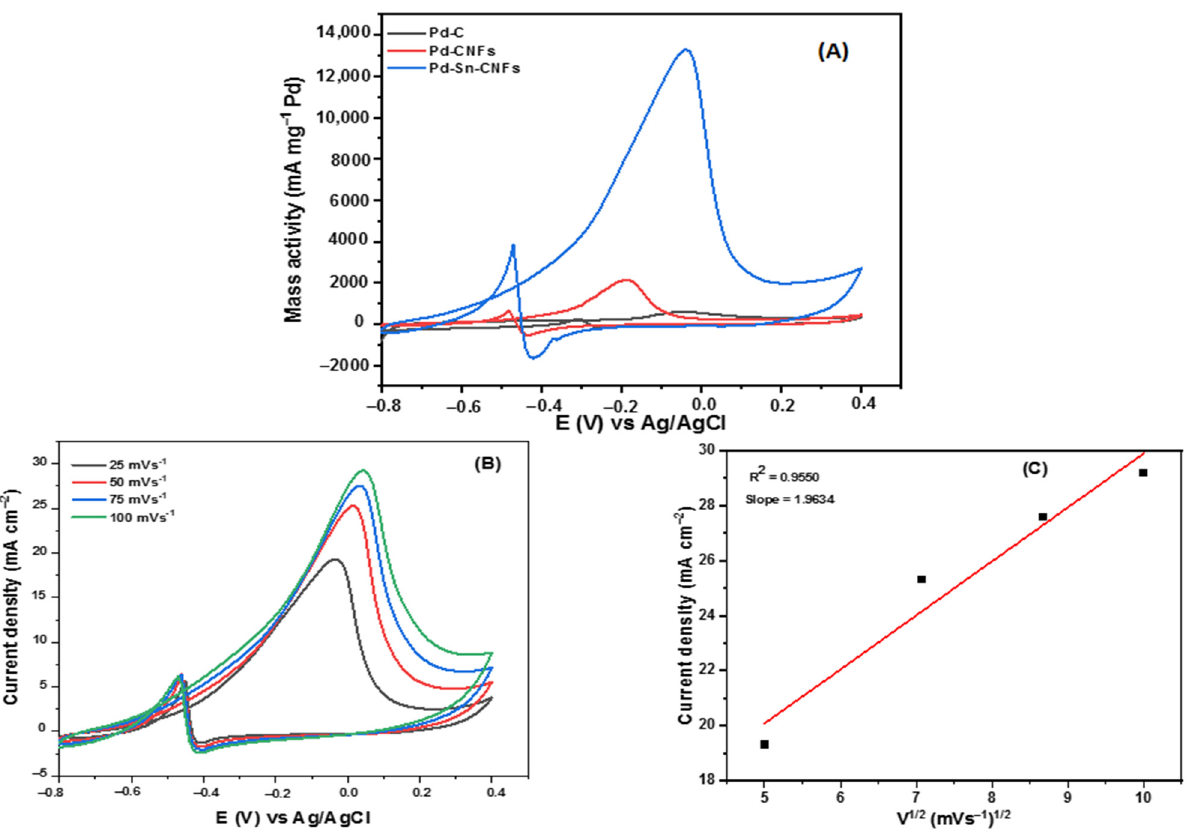
Figure 10. CV curve of Pd/C, Pd/CNFs and Pd-Sn/CNFs in 1 M KOH + 1 M CH 3 CH 2 OH ( A ) solution at a scan rate of 50 mVs − 1 at ambient temperature. CV curve of Pd-Sn/CNFs electro-catalyst in 1 M KOH + 1 M CH 3 CH 2 OH at various scan rates ( B ) and the relationship between peak current density and scan rates squared ( C ).